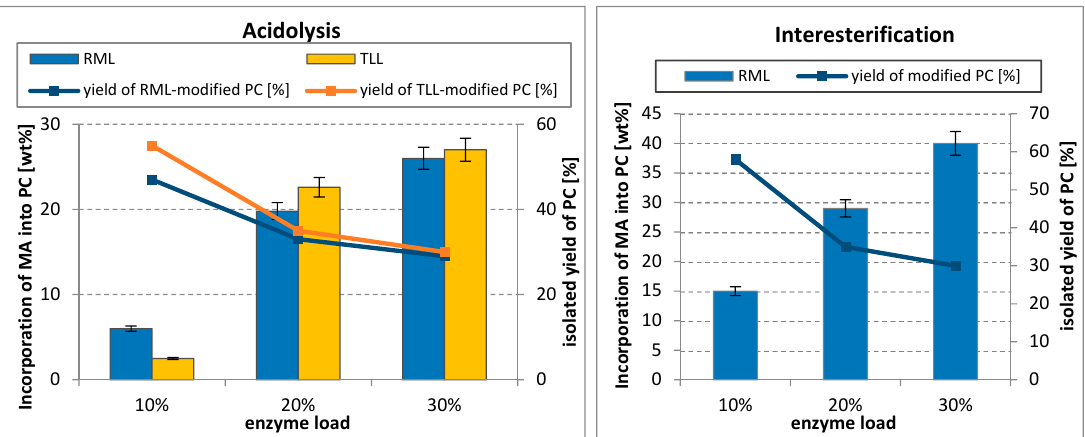
Figure 3. Effect of enzyme dosage on the incorporation of myristic acid into egg-yolk PC and isolated yield of modified PC in acidolysis and interesterification (reaction condition: temperature, 50–52 °C; PC/acyl donor molar ratio, 1/3; solvent, hexane; 48 h).